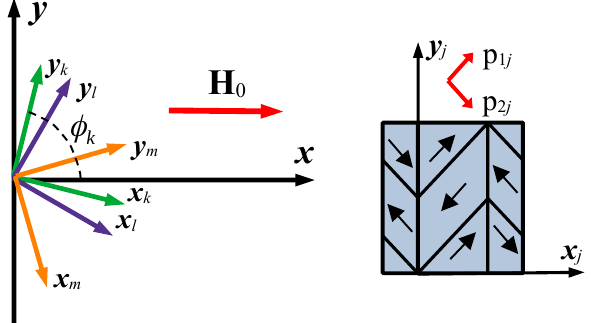
Figure 8. The distribution of twinned variants of martensite in a